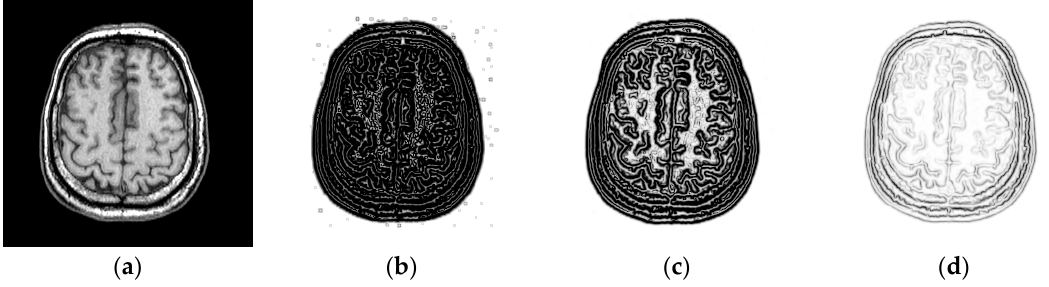
Figure 6. PSR of MR images by using the different thresholds. ( a ) T1-weighted MR image; ( b ) PSR with a small threshold; ( c ) PSR with an appropriate threshold; ( d ) PSR with a high threshold.